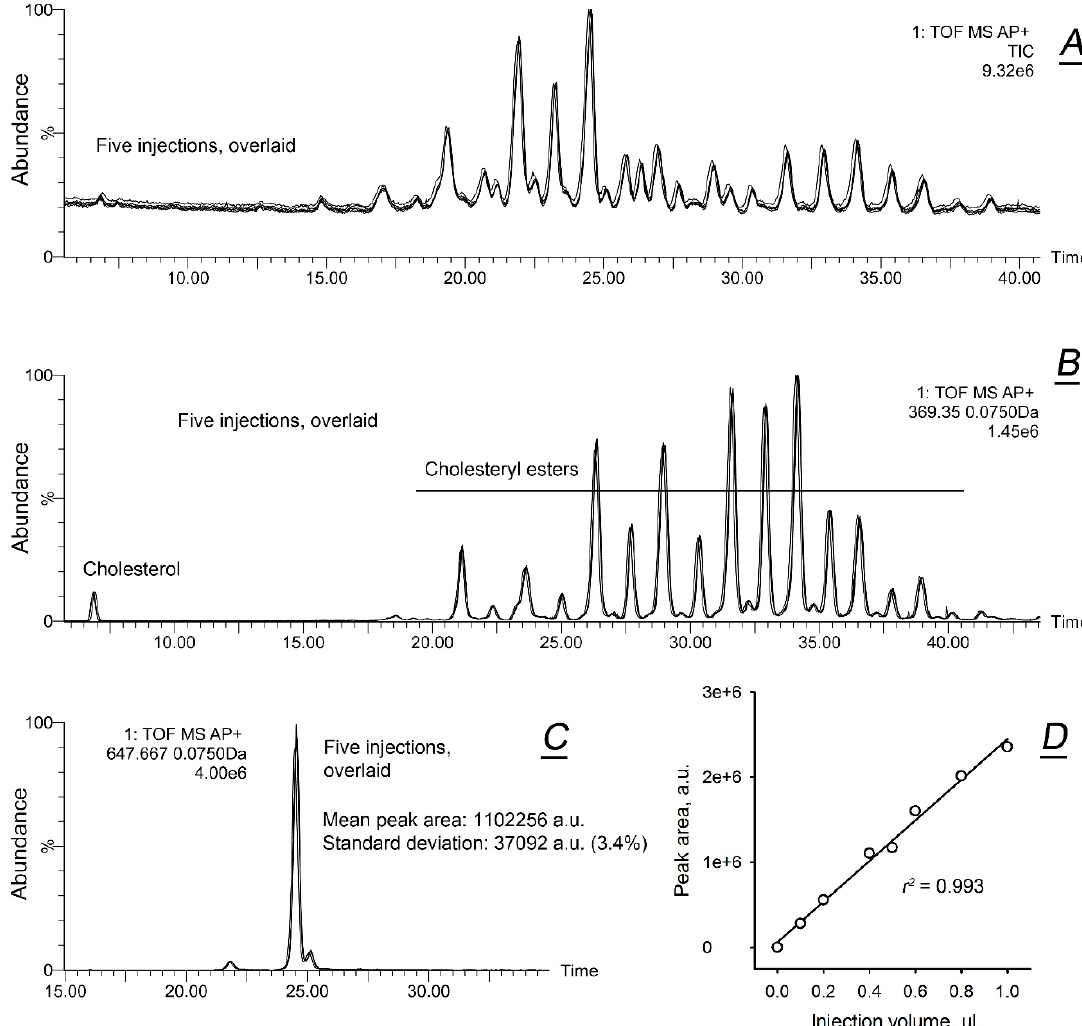
Figure 1. Validation of the reverse phase ultra-high performance chromatographic / mass spectrometric (RP-UPLC / MS) procedures. A representative sample of human meibum was analyzed five times using RP-UPLC / MS. ( A ) Five consecutive injections of a representative sample of human meibum produced identical total ion chromatograms (overlaid). ( B ) Five extracted ion chromatograms of ion m / z 369.355, overlaid. The ion is spontaneously produced by free cholesterol and all cholesteryl esters in positive ion mode TOF atmospheric pressure chemical ionization APCI (labeled as AP + ) MS experiments. ( C ) Five extracted ion chromatograms of ion m / z 647.667, overlaid. The ion is a proton adduct of a wax ester with a molecular formula of C 44 H 86 O 2 . The RP-UPLC / MS peak areas were determined by integrating the chromatographic traces using MassLynx software. ( D ) Evaluation of the linearity of the dose / signal curve produced by injecting various volumes of the same meibum solution. The analyte was the same C 44 H 86 O 2 meibum wax ester as in ( C ).